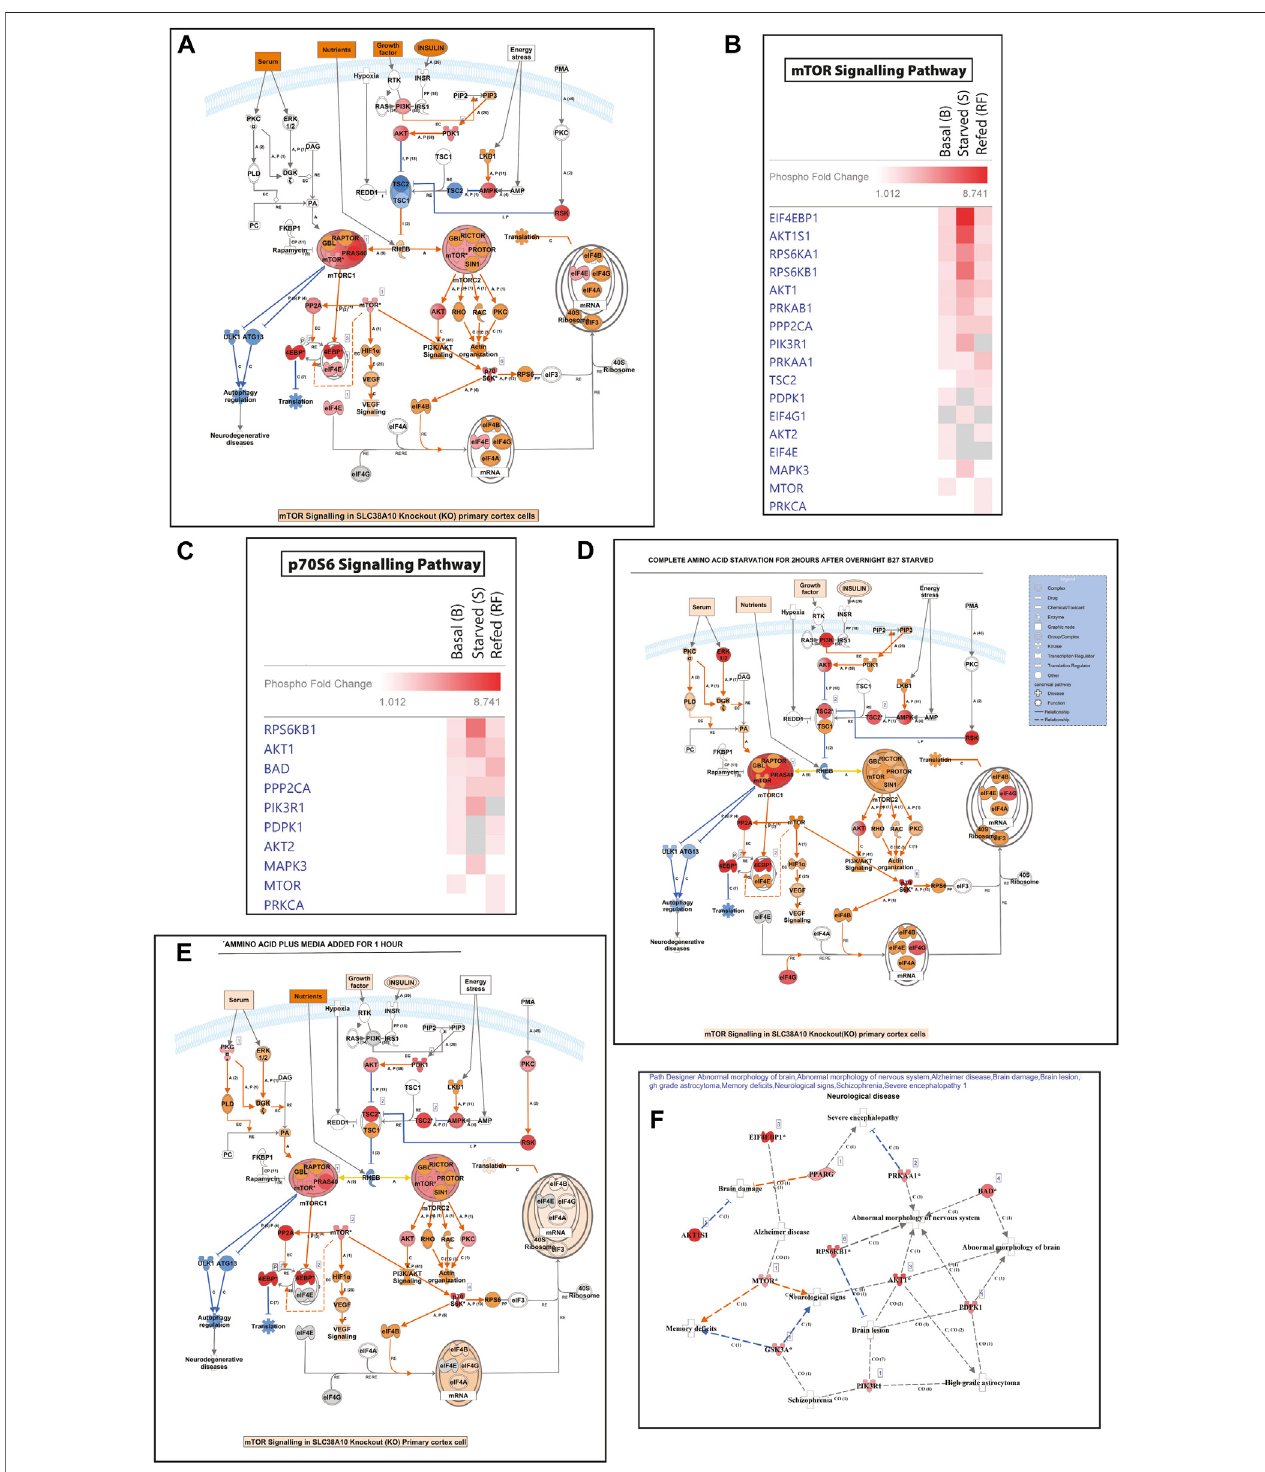
FIGURE 6 | The response in mTOR pathway and amino acid regualtion following SLC38A10 knockout. Complete transcriptomic data and changed gene list subjected to IPA software analysis. (A) Regulation in the mTOR pathway in response to SLC38A10 knockout in Basal condition, blue symbols indicate down regulation and red symbols up regulation. (B) Heatmap describing changes in transcript levels from the mTOR pathway during Basal, Starved and Refed conditions. (C) Heatmap describing changes in transcript levels from the p70S6 pathway during Basal, Starved and Refed conditions. (D) Regulation in the mTOR pathway in response to SLC38A10 knockout in Starved condition, blue symbols indicate down regulation and red symbols up regulation. (E) Regulation in the mTOR pathway in response to SLC38A10knockoutinRefedcondition,bluesymbolsindicatedownregulationand redsymbolsupregulation. (F) Neurologicaldiseasespredicted byPathDesigner,in response to SLC38A10